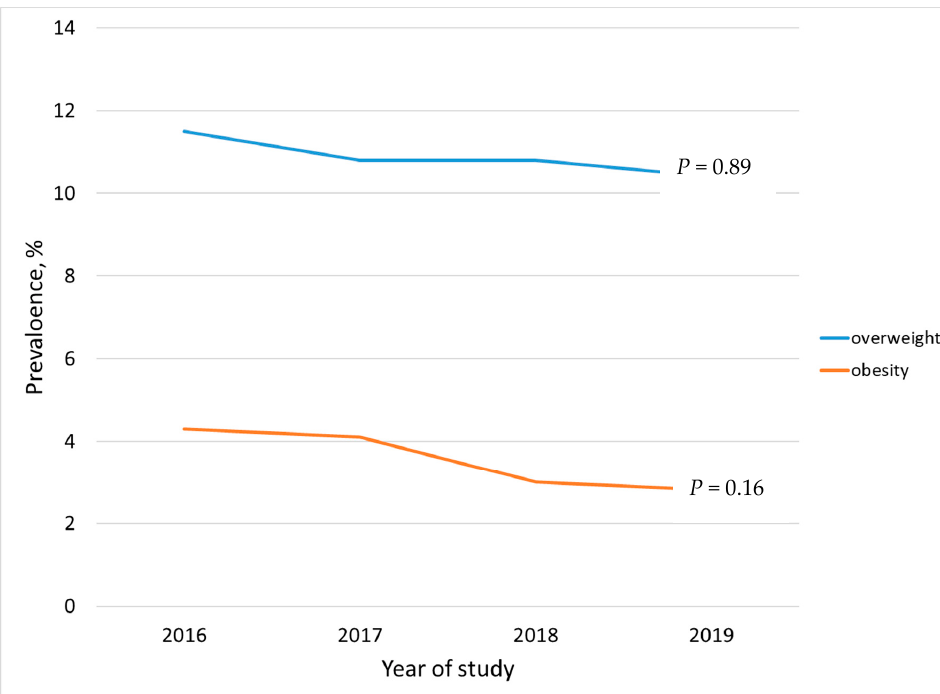
Figure 1. Trend of overweight and obesity prevalence among Kuwait children under 5 years (2016–2019). Figure caption: Chi-squared test was used to assess the prevalence change over time. Table 3. By year, distribution of breakfast skipping, sugary and sweetened beverages weekly consumption and daily screen time